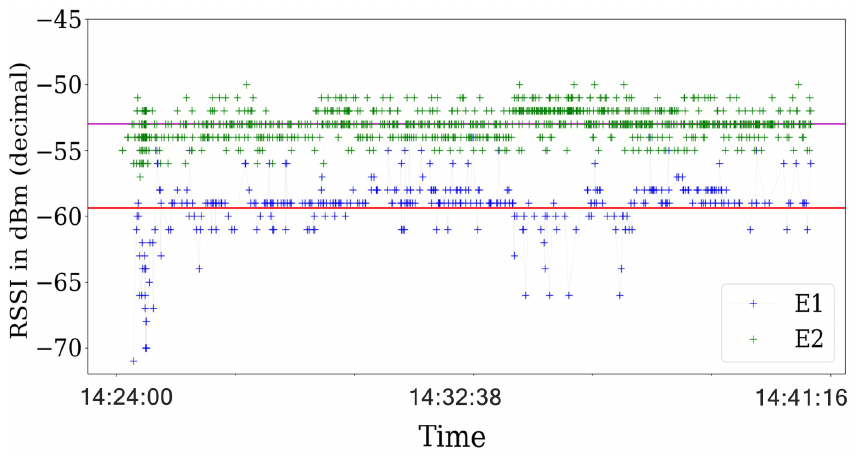
Figure 12. Events reported by the ACK in the communications for SINR = 3.1 with BE = 0 for the transmitter and the interferer as reactive. The presented behavior is the same for other time periods.